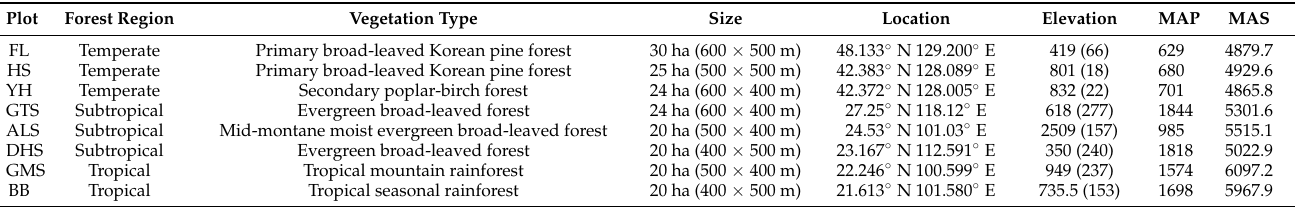
Figure 1. Locations of the 8 forest plots in China. Each solid point indicates a plot location, and the color represents the elevation in China. Table 1. Basic information of the eight plots in our study, including the abbreviation of the plot name, forest region, vegetation type, size, location, mean elevation and elevation difference in parentheses, mean annual precipitation (MAP) in millimeters (mm), and mean annual solar radiation (MAS) in MJ/m 2